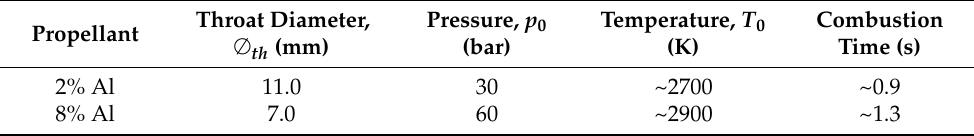
Table 1. Flow conditions in the combustion chamber.